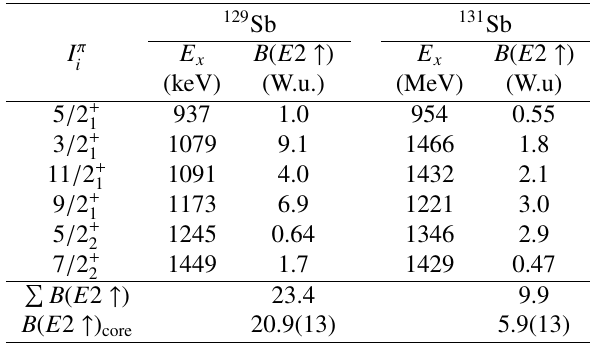
Table 5. Calculated B ( E 2) values for Sb isotopes. Core B ( E 2) values are from Refs. [5,